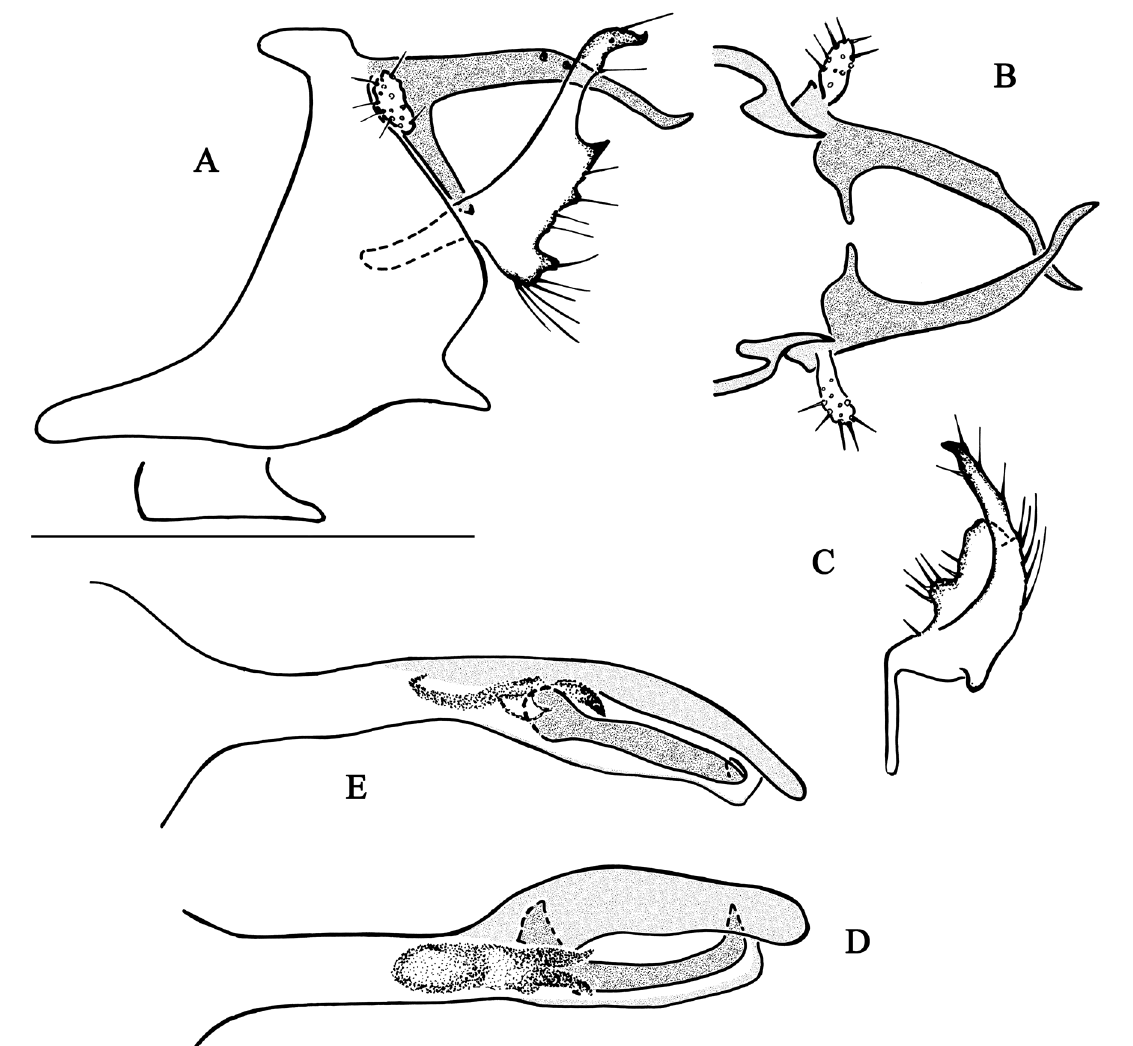
Fig. 13. Chimarra saha sp. nov. A–B . Abdominal segments IX and X. A . Lateral view with ventral margin of sternite VIII. B . Dorsal view (partim) . C . Inferior appendage, dorsal view. D–E . Phallic apparatus. D . Dorsal view. E . Lateral view. Scale bar = 0.5